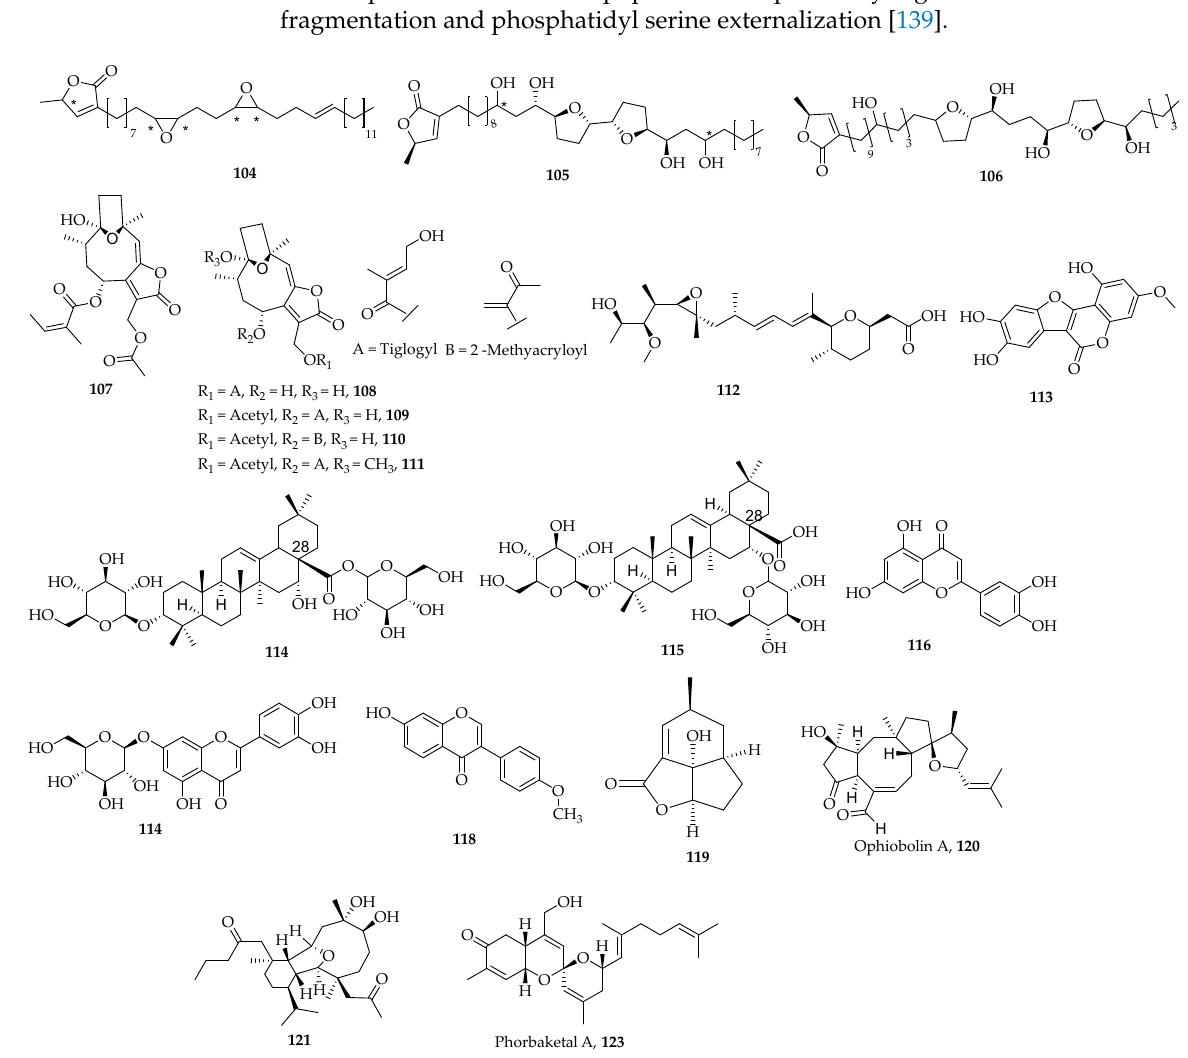
Figure 18. Structures of acetogenins 104 – 106 , sesquiterpene lactones, 107 – 111 and compounds isolated from Eclipta prostrata 113 – 117 .